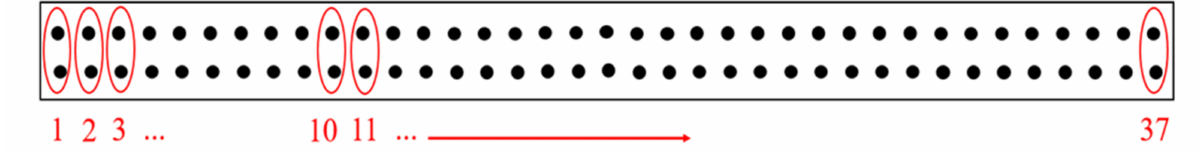
Figure 5. The top view of the steel beam showing the numbering of the shear stud rows.